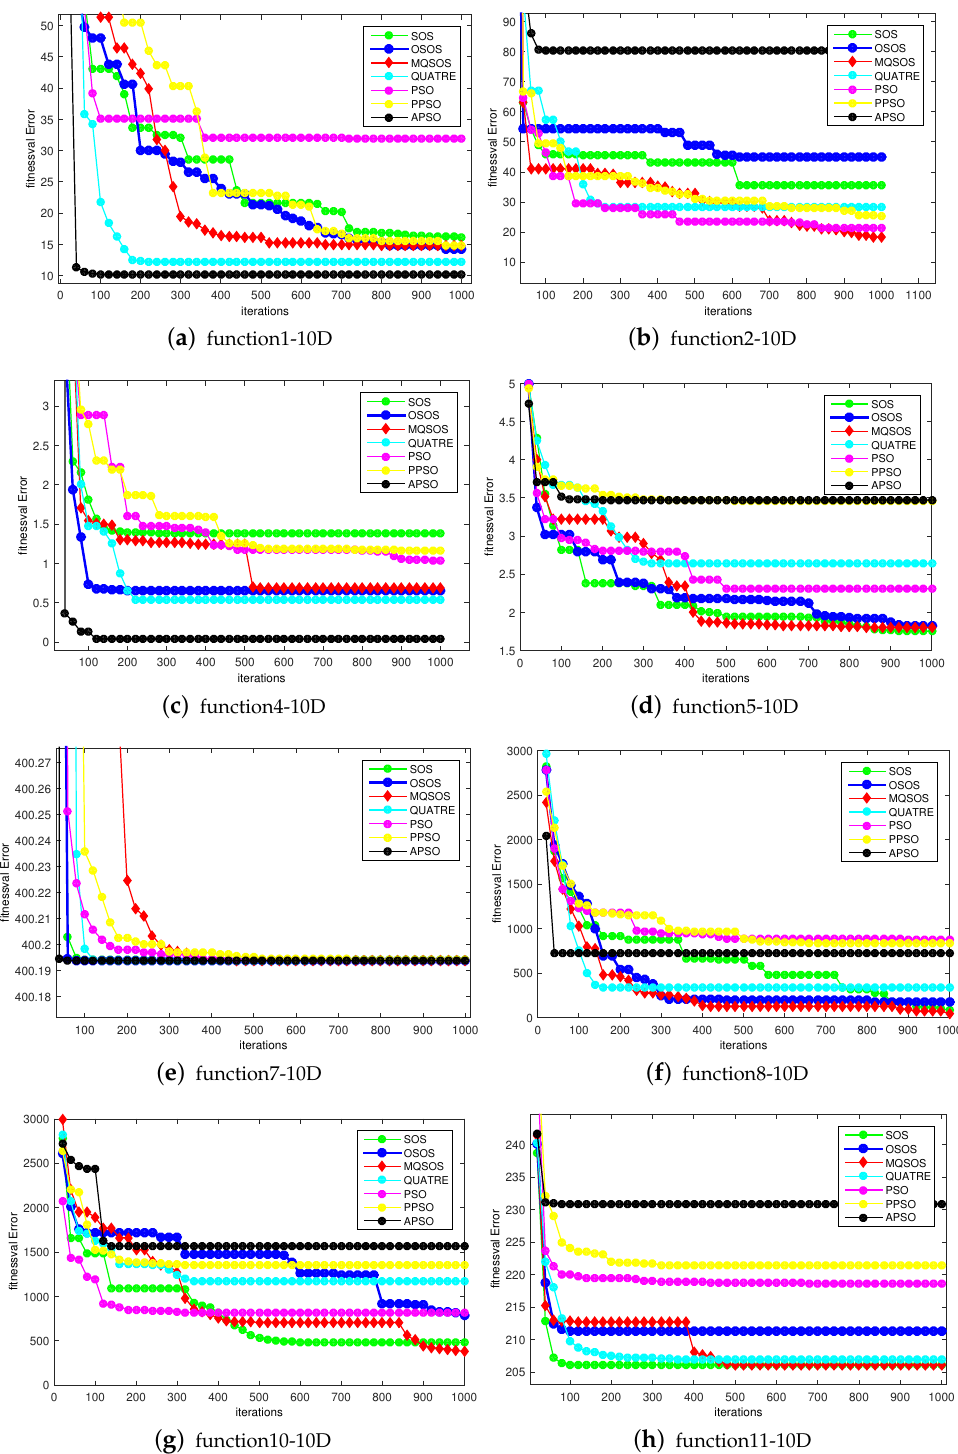
Figure 4. Comparison of the best fitnesses for functions f 17 − f 28 with 10D